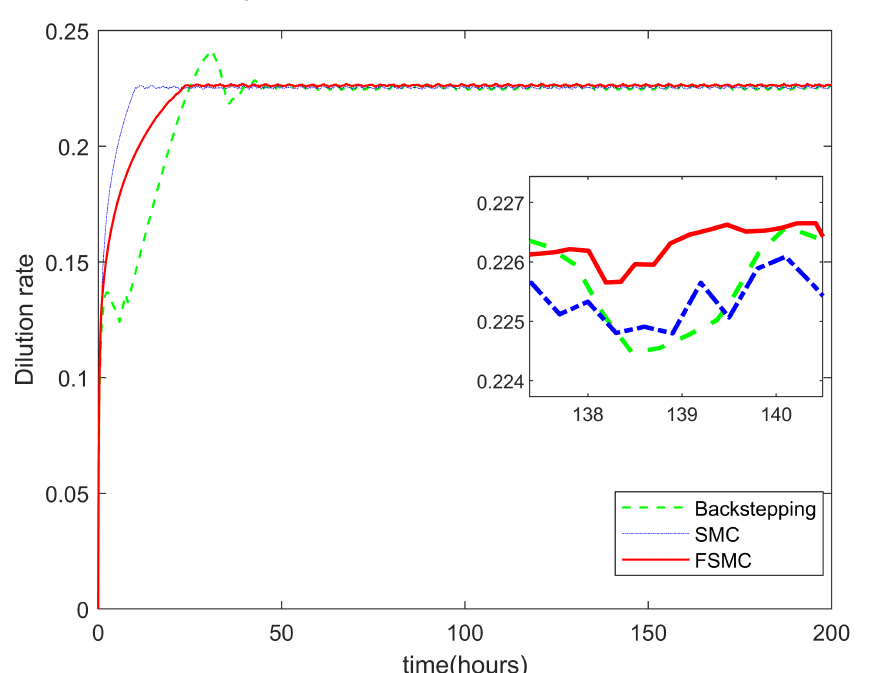
Figure 10. Anode voltage.